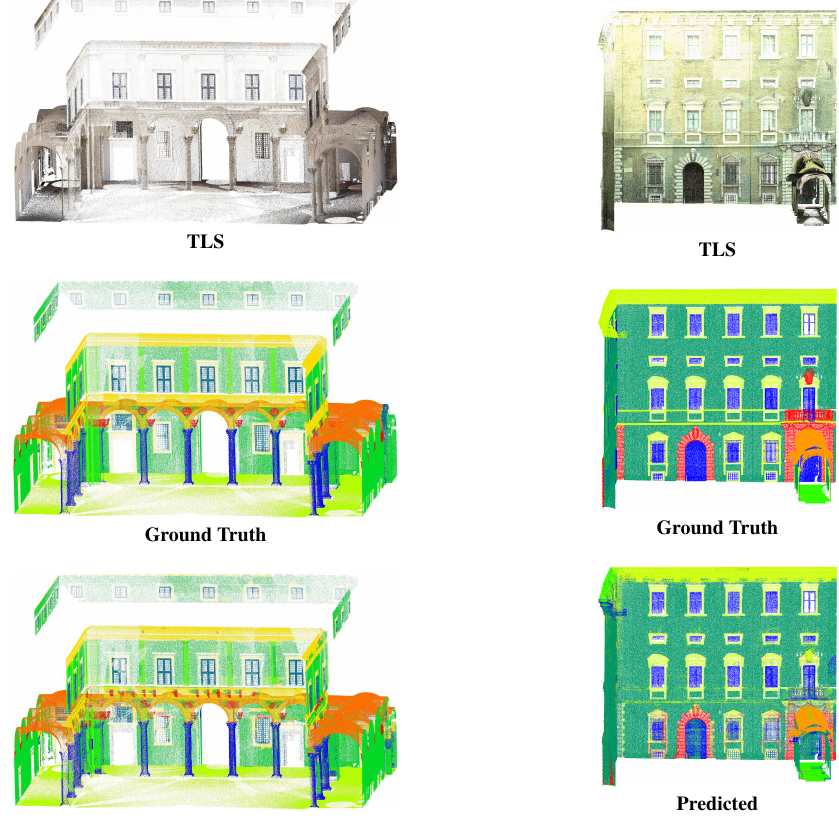
Table 2. Visualization of the result of the automatic segmentation of Ducal Palace at Urbino courtyard (left) and a view of the Palazzo Ferretti facade (right).